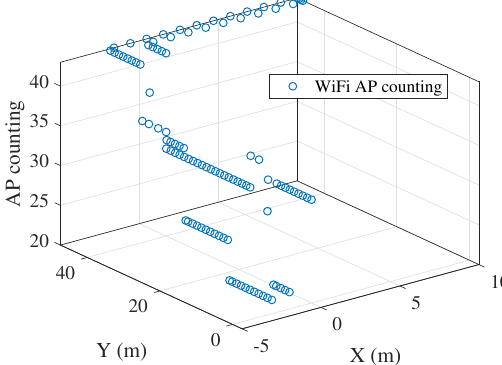
Figure 5. AP distribution.